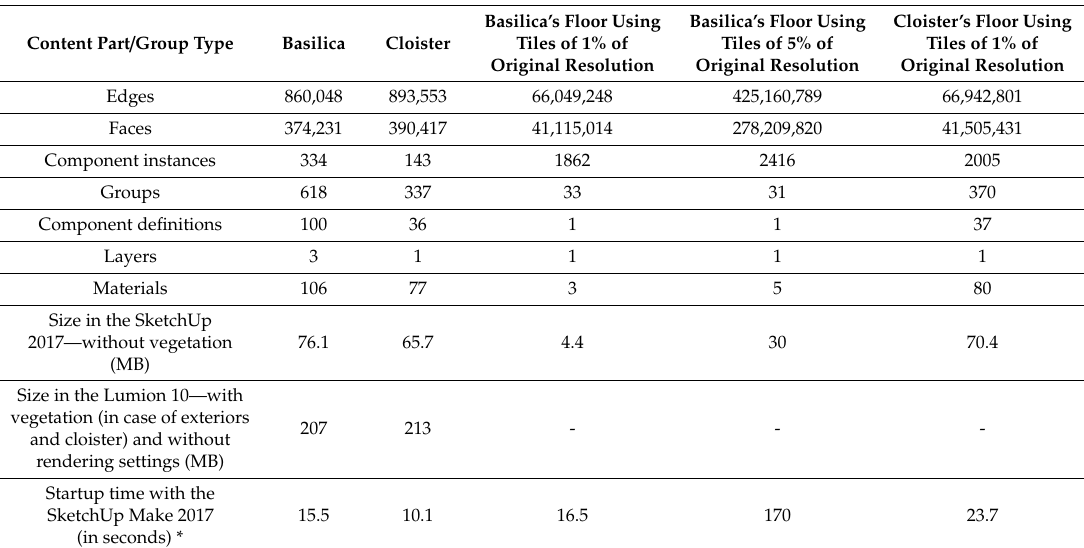
Table 4. Models of interiors—an overview of